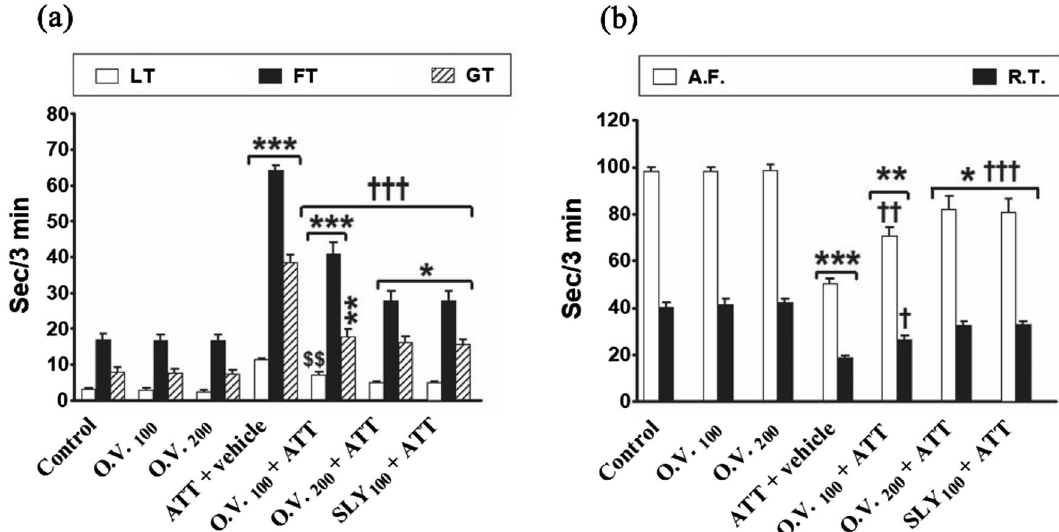
Figure 4. The modulatory effects of O. vulgare on latency time, freezing time, and grooming frequency ( a ) and ambulation and rearing frequencies ( b ) in OFT in the HE-induced rat model. SEM represented by vertical bars. AF: ambulation frequency, FT: freezing time, GF: grooming frequency, LT: latency time, O.V . : Origanum vulgare , RF: rearing frequency, SLY: silymarin. * p < 0.05; ** p < 0.01; *** p < 0.001 (vs. the negative control